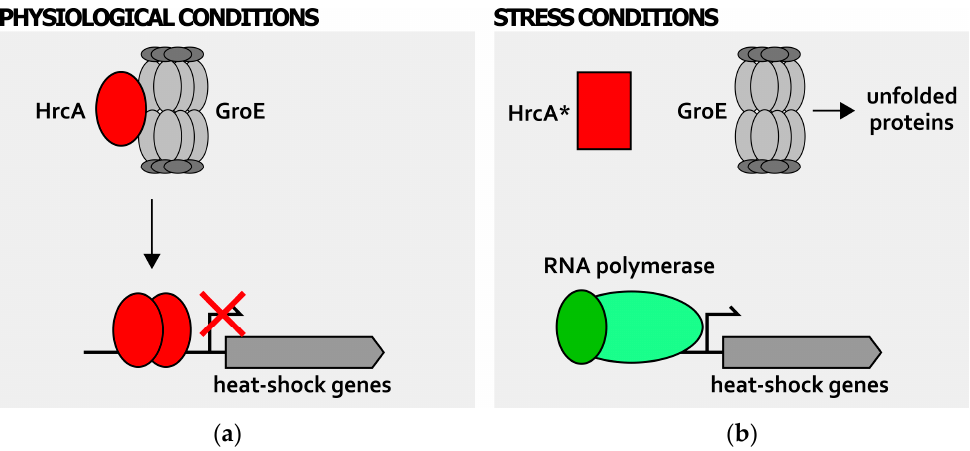
Figure 3. Posttranscriptional regulation of heat-shock genes expression: GroE-mediated regulation of HrcA activity. During physiological growth conditions ( a ), the GroE chaperonine (represented in grey as a multisubunit complex) is free to interact and fold the HrcA regulator (red oval). Once properly folded, this repressor binds and occupies its target promoters, repressing genes transcription; when cells experience stress conditions of growth ( b ), GroE is titrated by unfolded proteins that accumulate in the cytoplasm and cannot interact with HrcA. The repressor, left alone, has a conformation with low DNA-binding affinity (red rectangle, HrcA*) and HrcA-dependent heat-shock genes’ repression is relieved. The RNA polymerase containing the vegetative σ factor is represented by green ovals (dark green oval depicts vegetative σ factor, while light green oval represents the core RNA polymerase). Bent arrow indicates the transcription start site.